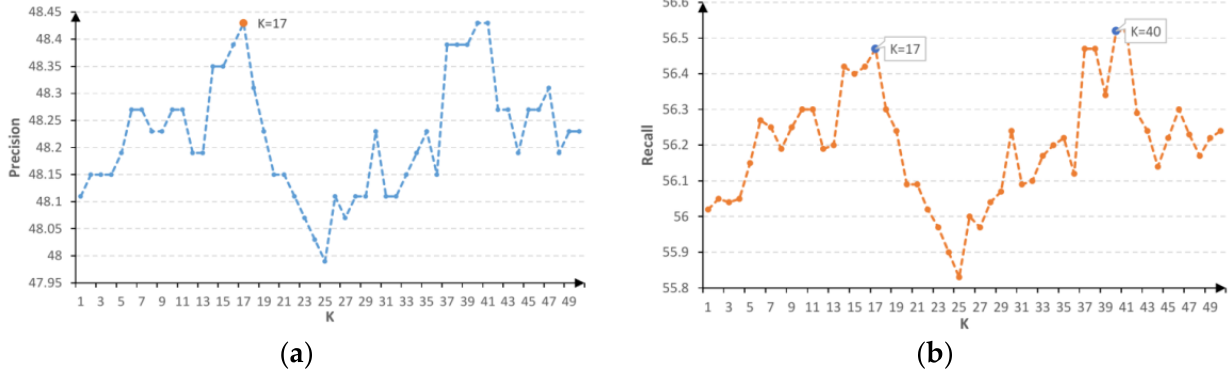
Figure 5. The impact of changing the value of K of KNN regressor on ( a ) the precision and ( b ) the recall of our proposed method.